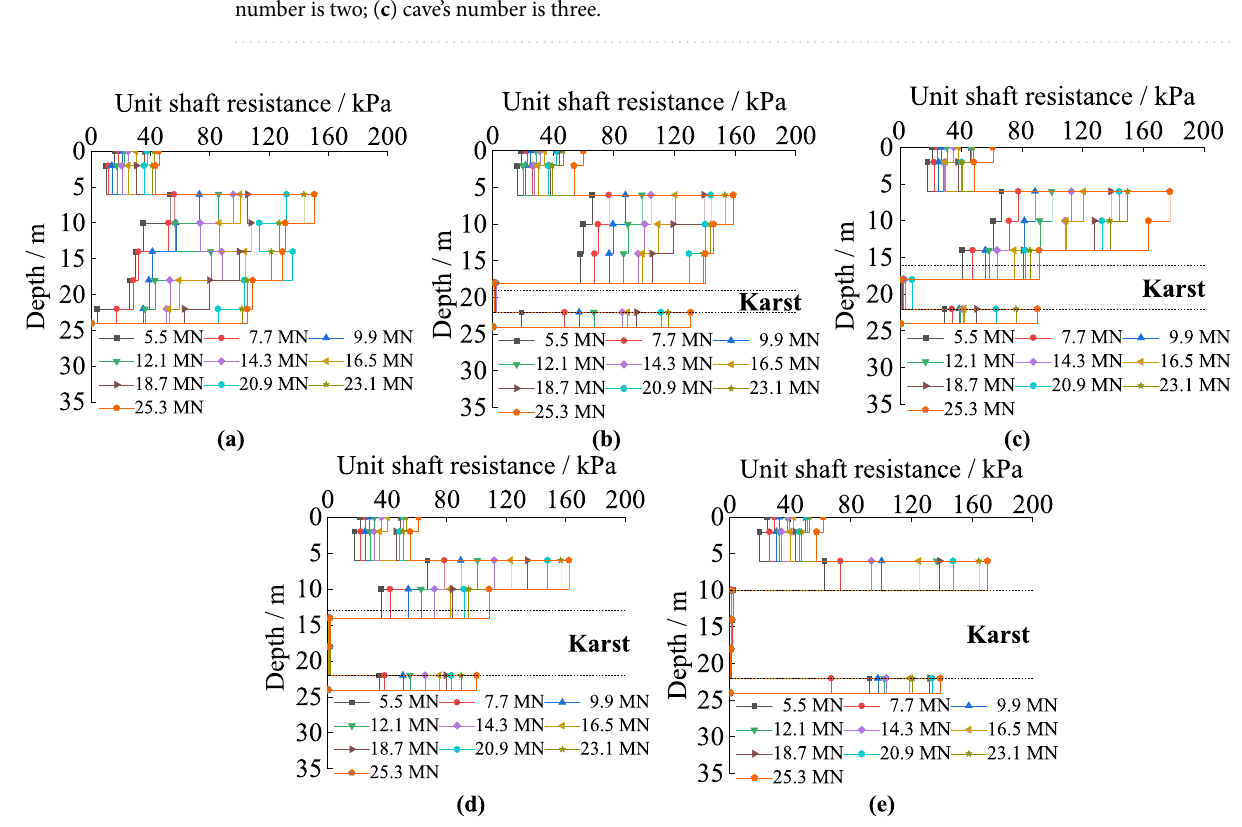
Figure 6. The unit shaft resistance of piles with different karst cave heights: ( a ) no cave; ( b ) cave’s height is 3 m; ( c ) cave’s height is 6 m; ( d ) cave’s height is 9 m; ( e ) cave’s height is 12